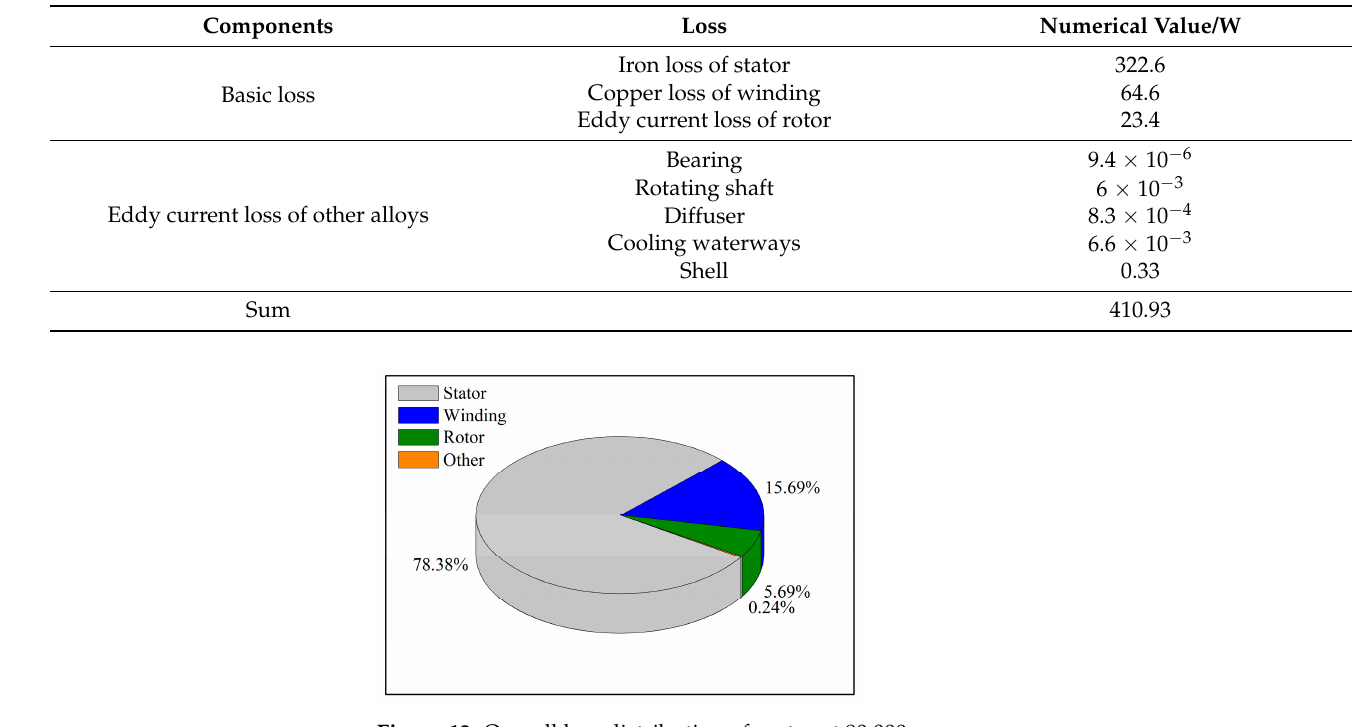
Figure 12. Overall loss distribution of motor at 80,000 rpm.